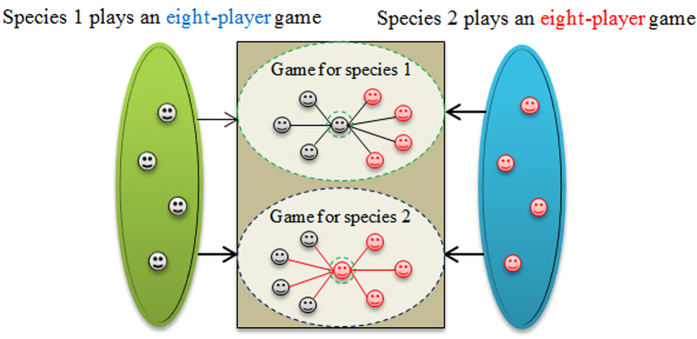
Illustration of interactions between species 1 and 2 in mutualisms.We assume that the number of members of each species is four. Species 1 and 2 both play in an eight-player game. In this first game, we choose one player of species 1 (the grey faces) to interact with remaining players species 1 and four players of species 2 (the red faces). Species 2 plays an eight-player game too. In this second game, one player of species 2 joins and interacts with remaining players species 2 and all the players of species 1.